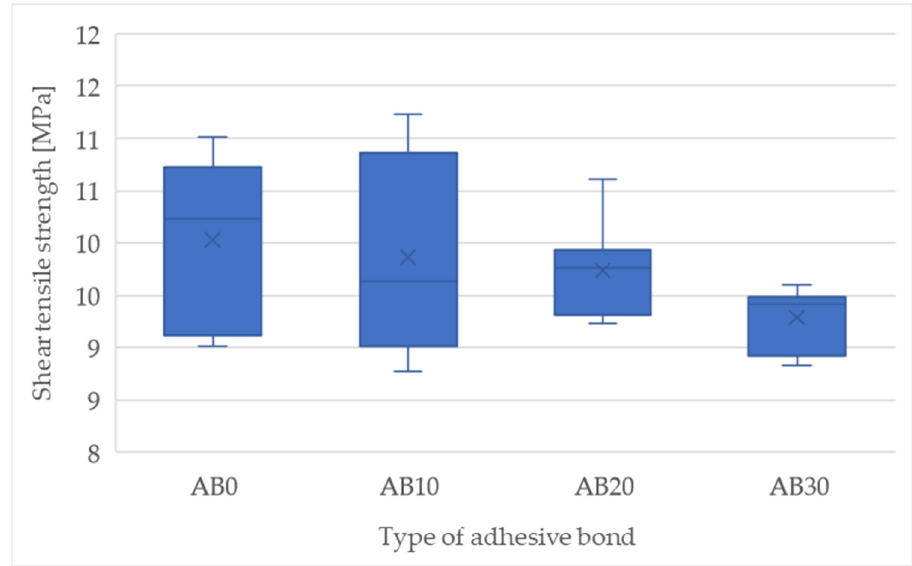
Figure 4. Shear tensile strength of adhesive bonds in static tensile test. Statistical testing showed statistically insignificant differences between AB0 and AB10 ( p = 0.72), AB20 ( p = 0.40), that is, the filler concentration did not significantly affect the static strength of the AB10 and AB20 adhesive bonds. A statistically significant difference was demonstrated for the AB30 adhesive bond ( p = 0.04), that is, the filler concentration significantly (negatively) affected the static strength of the AB30 adhesive